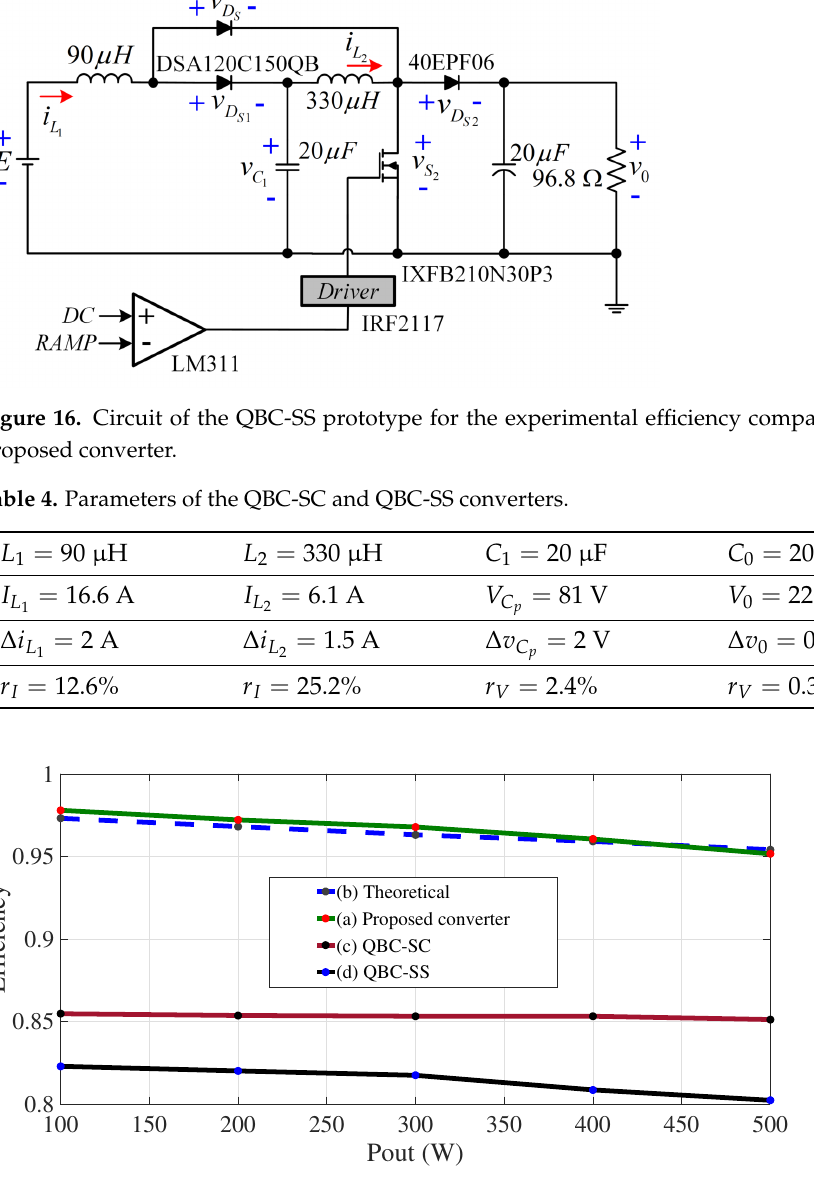
Figure 17. Comparison of power efficiencies. (From top to bottom) (a) Proposed converter, (b) theo- retical efficiency, (c) QBC-SC, and (d) QBC-SS.